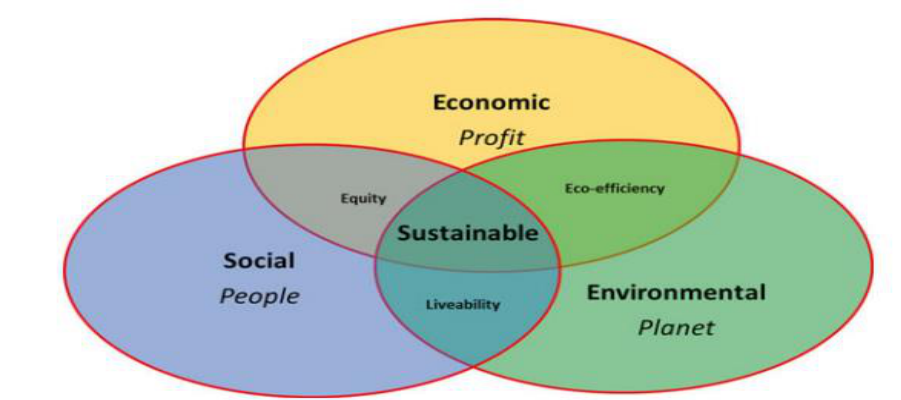
Figure 2: The Triple Bottom